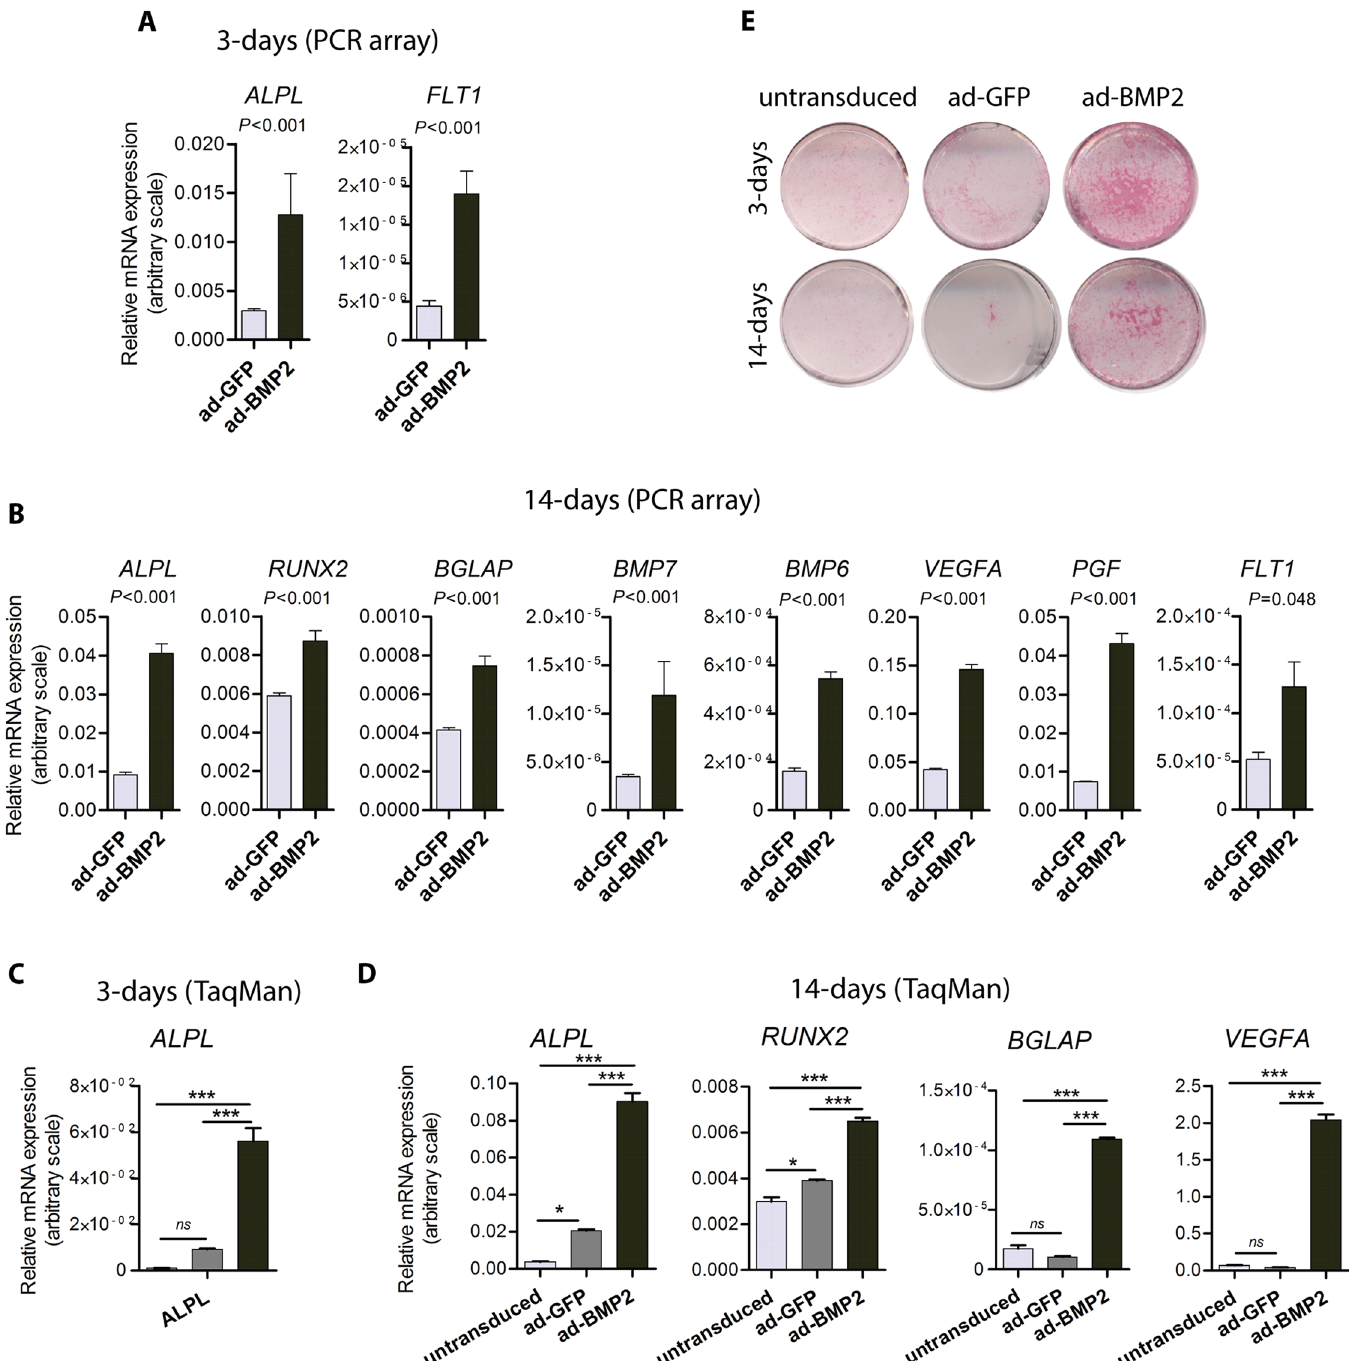
Fig 2. BMP2 over-expression led to up-regulation of osteogenic and angiogenic molecules in vitro. 5 × 10 4 ad-BMP2 or ad-GFP BMSC were seeded in each Poly(LLA-co-CL) scaffolds and harvested after 3 and 14 days for custom PCR array and TaqMan based qRT-PCR. (A) With SAM analysis, ALPL and FLT1 mRNA levels were found to be significantly (FDR = 0) up-regulated at 3-days in ad-BMP2 BMSC. (B) More osteogenic and angiogenic markers were significantly induced at 14-days in ad-BMP2 BMSC as compared to the ad-GFP BMSC group. (C and D) Array results for ALPL , RUNX2 , BGLAP and VEGFA genes were independently validated in ad-BMP2 BMSC by using TaqMan qRT- PCR. Error bars represent SEM of 3 repeated experiments ( n = 3) done in 3 technical replicates. ANOVA test with Bonferroni post hoc analysis was performed for statistical analysis in C and D. *** , p < 0.001; * , P < 0.01; ns, non- significant. (E) Representative images demonstrating higher alkaline phosphatase activity in ad-BMP2 BMSC in monolayer as compared to the ad-GFP BMSC and untransduced BMSC. Experiments were repeated at least three times.